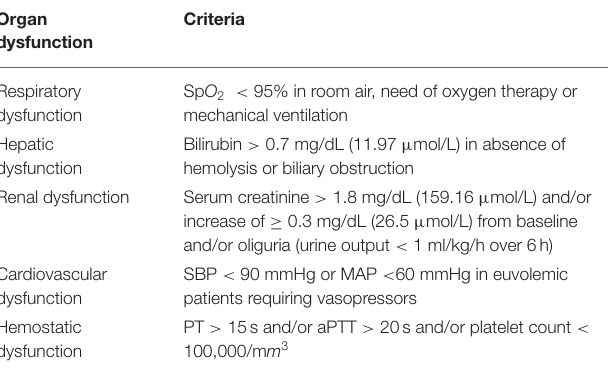
TABLE 1 | Criteria for organ dysfunction in cats (3). Organ